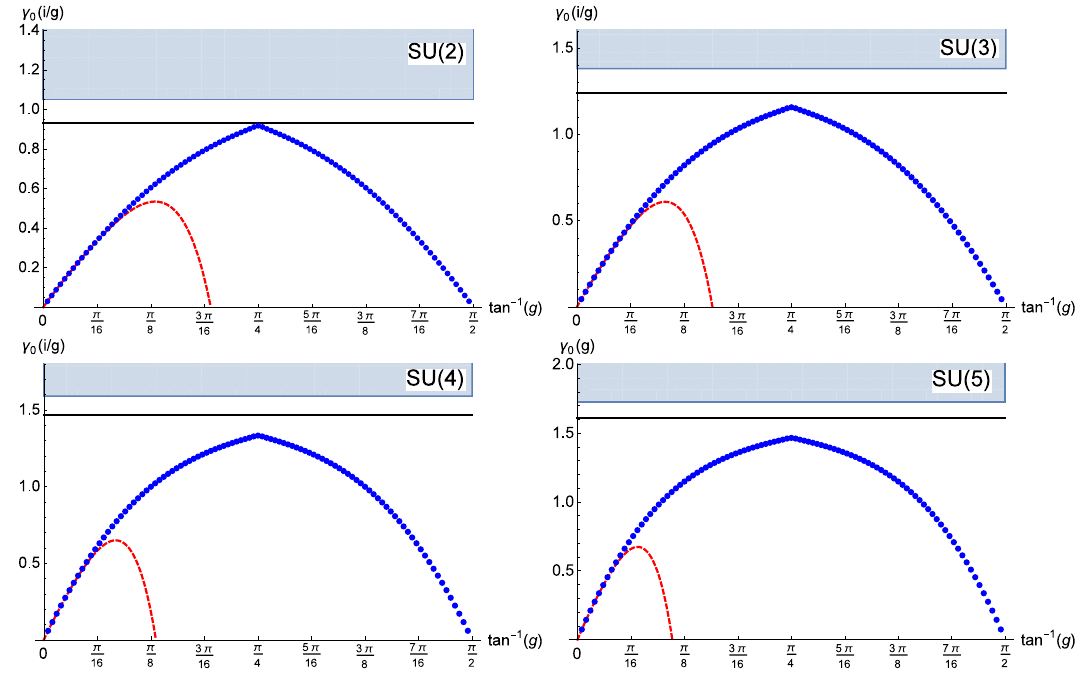
( (cid:28) = i=g ) for the spin-0 operator is plotted against Figure 3 . The interpolating function F (30 ; 1 = 4) 4 the gauge coupling g for (cid:18) = 0 (blue dots). The red dashed line denotes the weak coupling expansion up to four loop. The shaded region and horizontal black solid line are the upper bounds and corner values obtained by the N = 4 superconformal bootstrap,